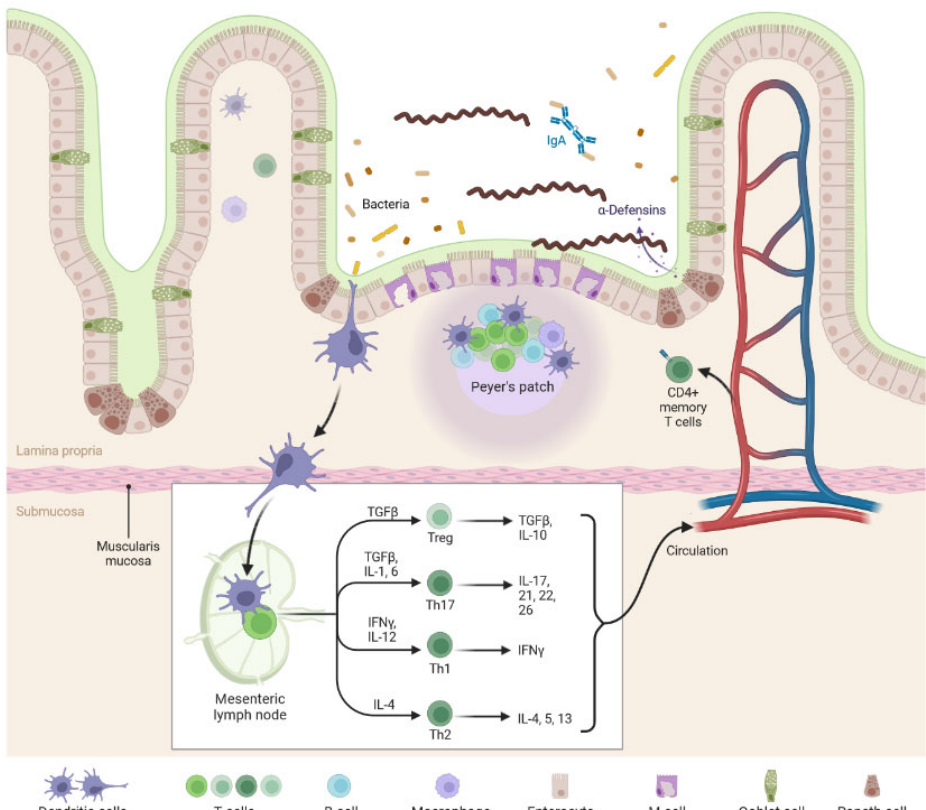
Figure 4. Commensal bacteria can influence the induction of intestinal T ‐ helper cells in Gut ‐ associated lymphoid tissue. Altered intestinal T helper cell profiles can have pathological consequences that are not limited to intestinal sites.